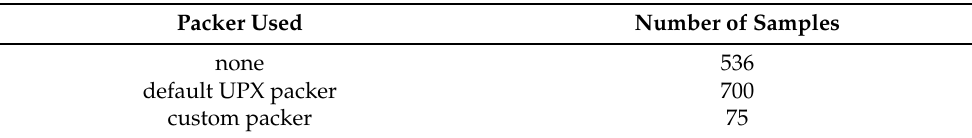
Table 4. Packer used per number of IoT botnet samples. Packer